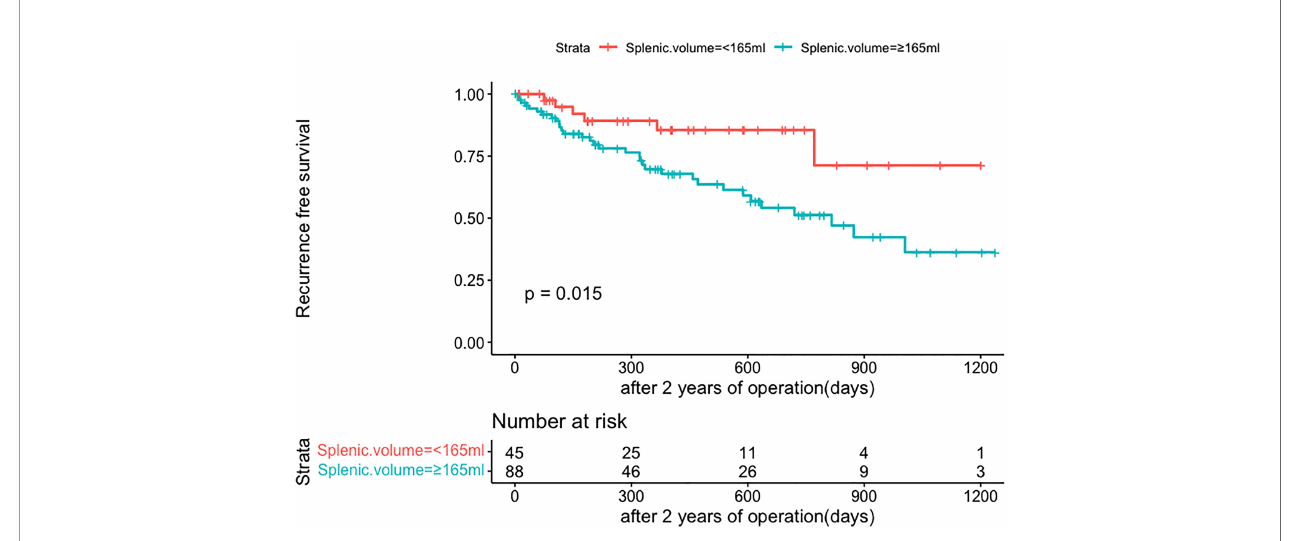
FIGURE 5 | Comparison of RFS in late recurrence patients between two groups (SV<165ml, SV ≥ 165ml). RFS, recurrence-free survival; SV, splenic